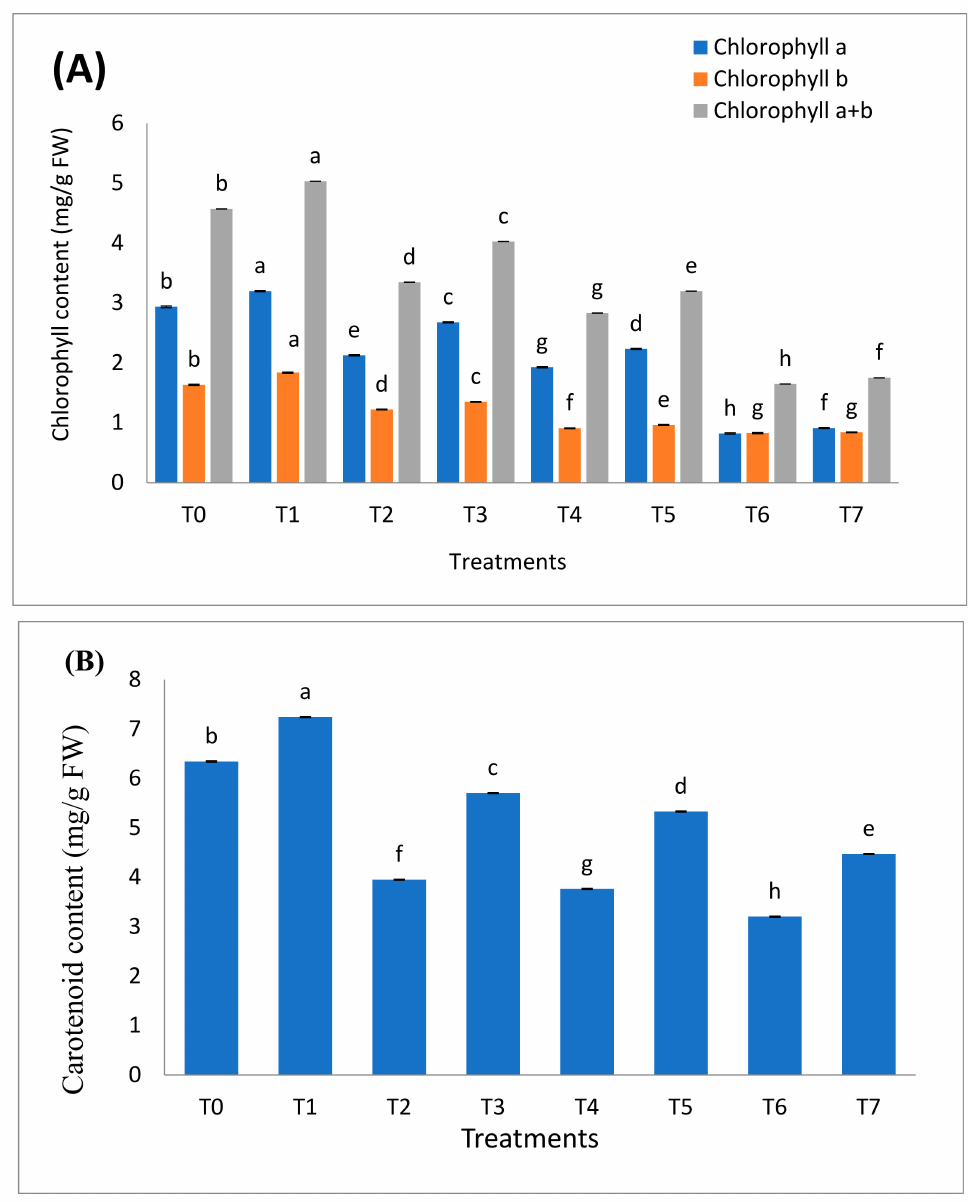
Figure 2. Effect of B. cereus inoculation on ( A ) chlorophyll content and ( B ) carotenoid content of B. nigra . facing chromium stress. Where T0 = Control, T1 = B. cereus , T2 = Cr-20 mg/kg, T3 = Cr-20 mg/kg + B. cereus , T4 = Cr-30 mg/kg, T5 = Cr- 30 mg/kg + B. cereus , T6 = Cr-40 mg/kg, T7 = Cr-40 mg/kg + B. cereus . Mean and standard deviations are shown in the figure. Different letters indicate significant differences between means of treatments at p < 0.05 according to LSD